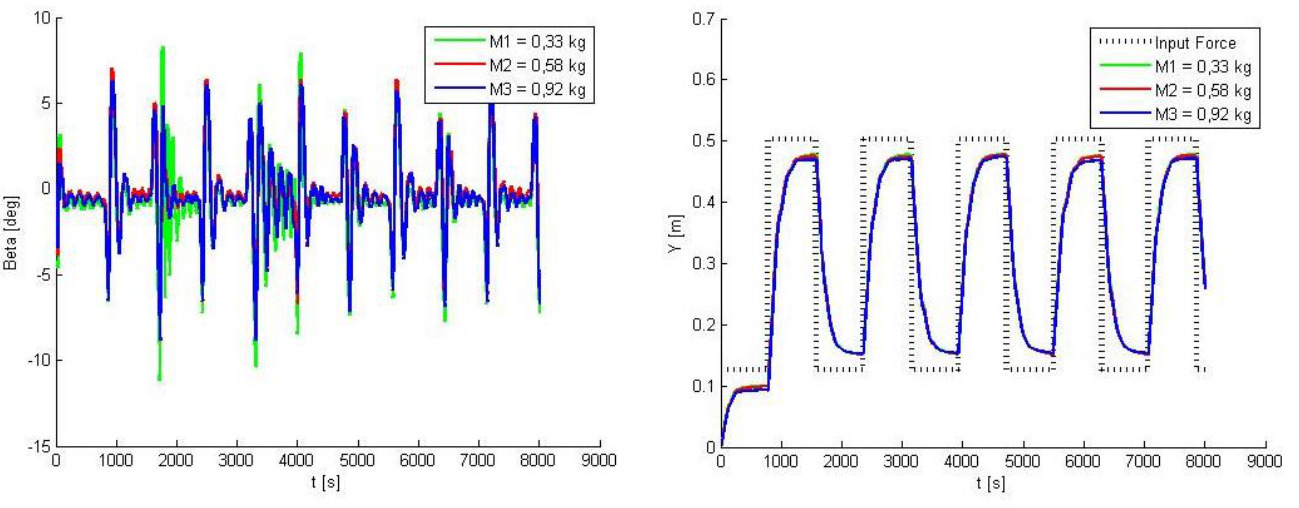
Fig. 10. Anti-swing 5DOF PI regulator  angle of the payload oscillation simulation results.